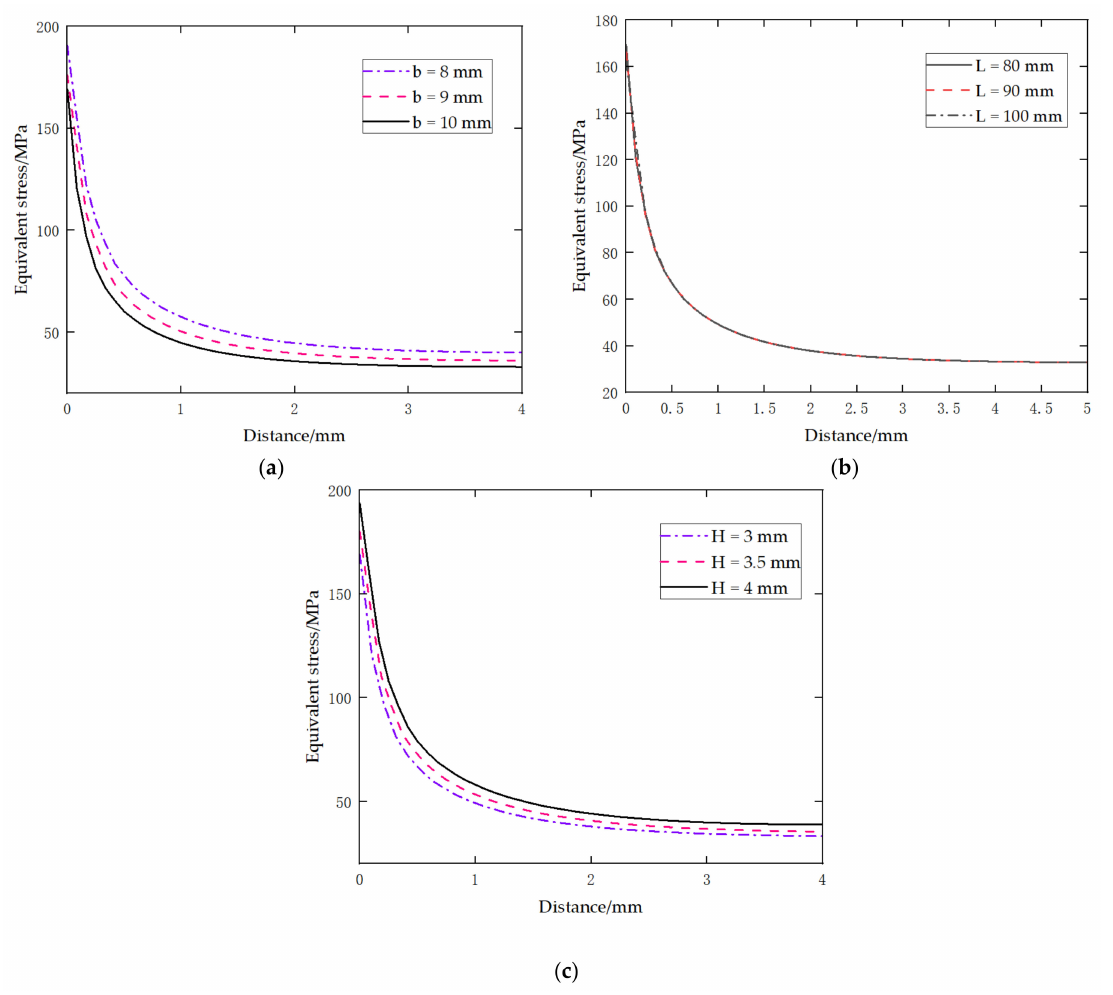
Figure 3. Research results of structural dimensions: ( a ) only change the net width; ( b ) only change the length; ( c ) only change the notch